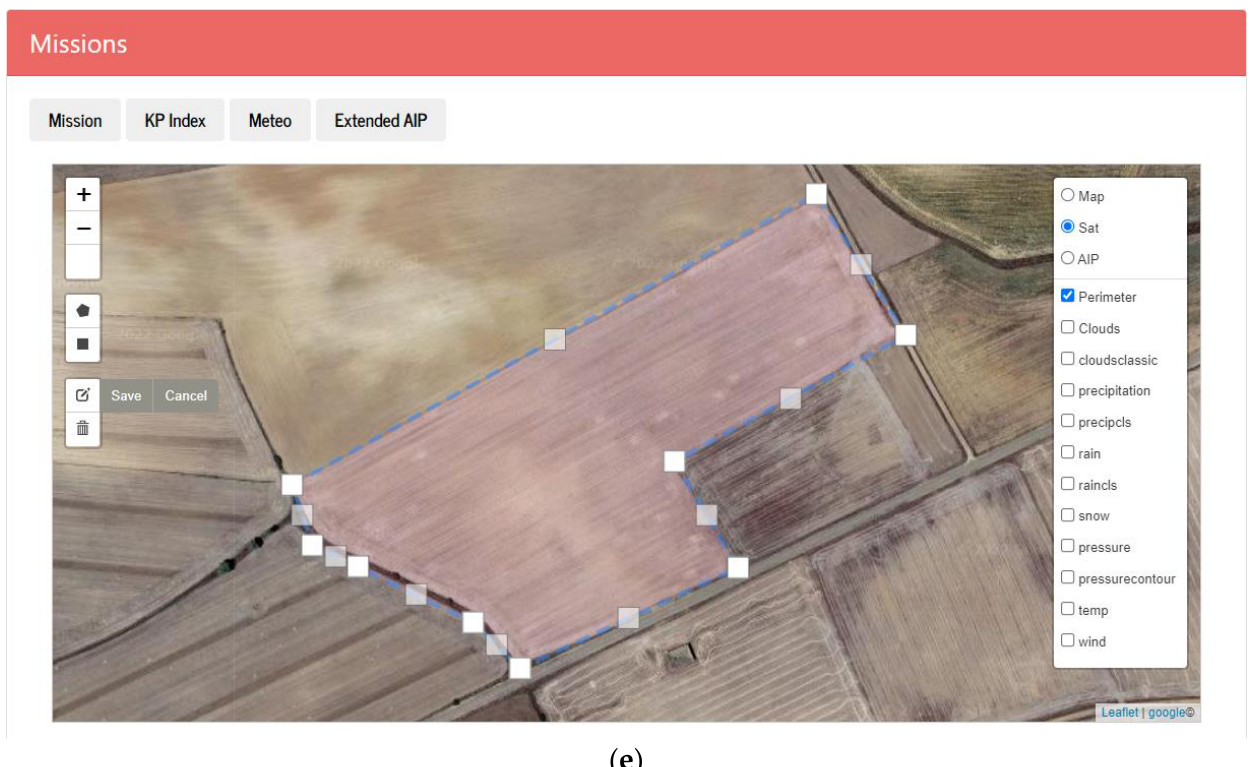
Figure 4. Some snapshots: ( a ) Observation of the KP index, ( b ) Temperature prediction, ( c ) map with AIP information, ( d ) Advanced AIRMAP viewer, ( e ) Route planning.